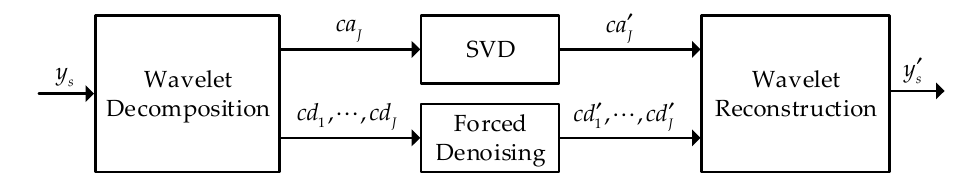
Figure 2. Block diagram of the proposed filter.